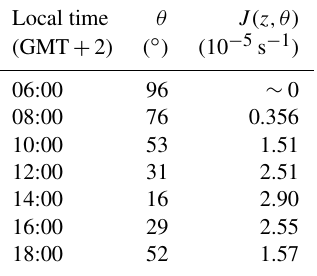
Table 5. Estimated photolysis rate coefficients of 2-methylbutanal at sea level ( z = 0km) in the summer solstice day in Valencia